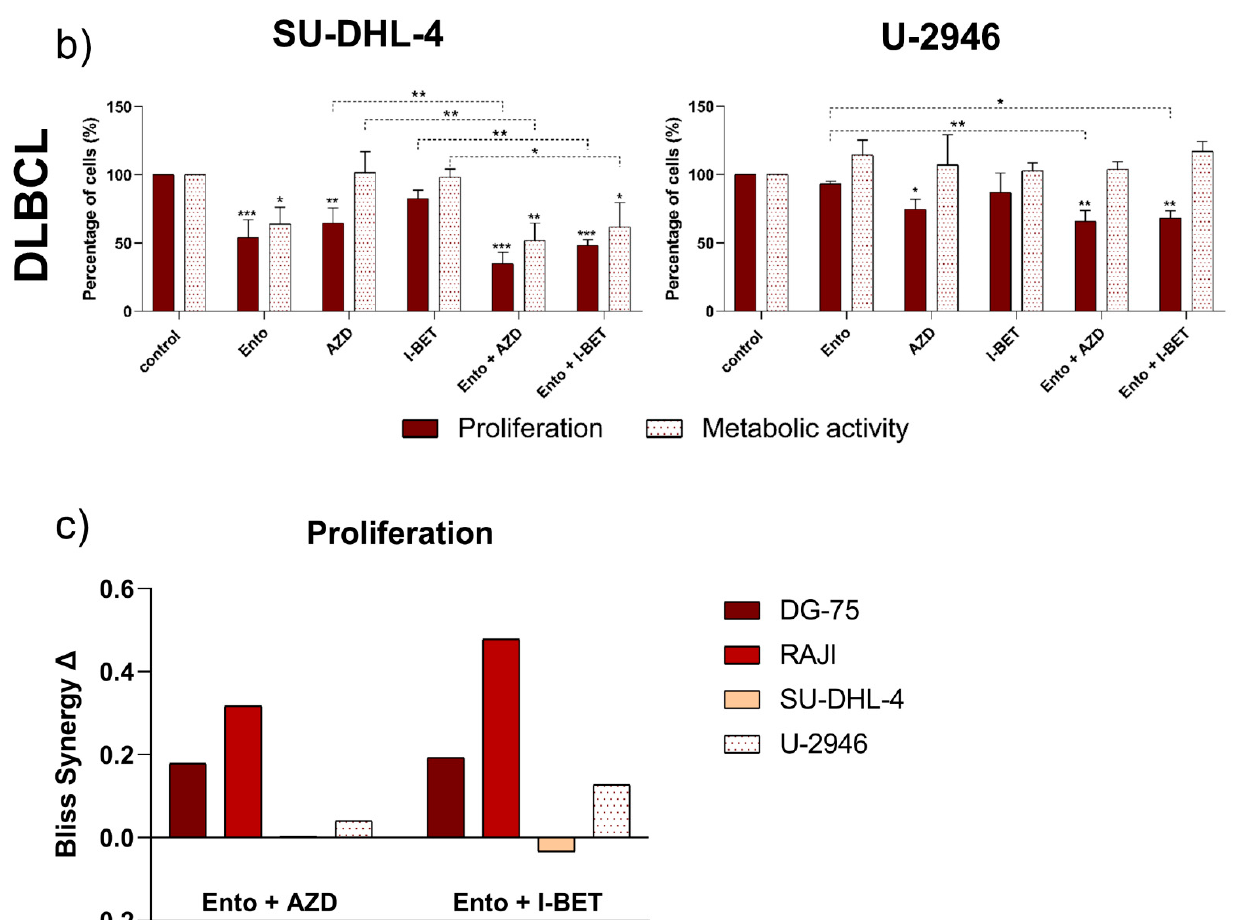
Figure 2. Simultaneous BET and SYK inhibition affected cell viability of BL and DLBCL cell lines synergistically. Cells were exposed to 1 µ M Ento, 0.01 µ M AZD or 0.1 µ M I-BET as a single agent or in combination. Cell proliferation and metabolic activity were assessed in ( a ) BL cell lines (DG-75 and RAJI) and ( b ) DLBCL cell lines (SU-DHL-4 and U-2946) after 72 h. ( c ) Bliss calculations were based on proliferation. Synergistic effects of both combinations were calculated with a Bliss Independence model (EA+EB–EAEB). A value Δ = 0, >0 and <0 defines an additive-, synergistic- or antagonistic interaction, respectively. Data are presented as the mean ± SD. Statistical significance of cell viability data was calculated by one-way ANOVA followed by Tukey’s multiple comparison test as a post hoc analysis and displayed as * p < 0.033, ** p < 0.002, *** p < 0.001 versus control group and further versus the respective single agents (dashed line) (n ≥ 3).